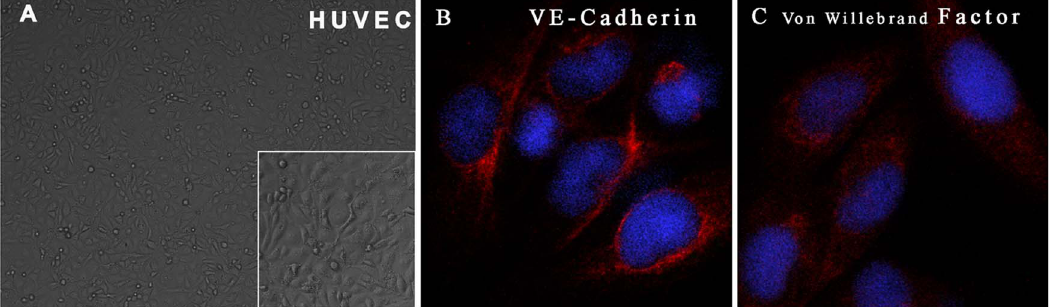
Fig. 3. Characterization of HUVECs by morphology and immunofluorescence. (A) Confluent cells exhibited typical cobblestone morphology; insert image at 200X magnification. (B and C) Immunofluorescence of samples labeled for VE-cadherin (B) or Von Willebrand factor (C). The immunoreactive positive cells were stained red and imaged at 400X